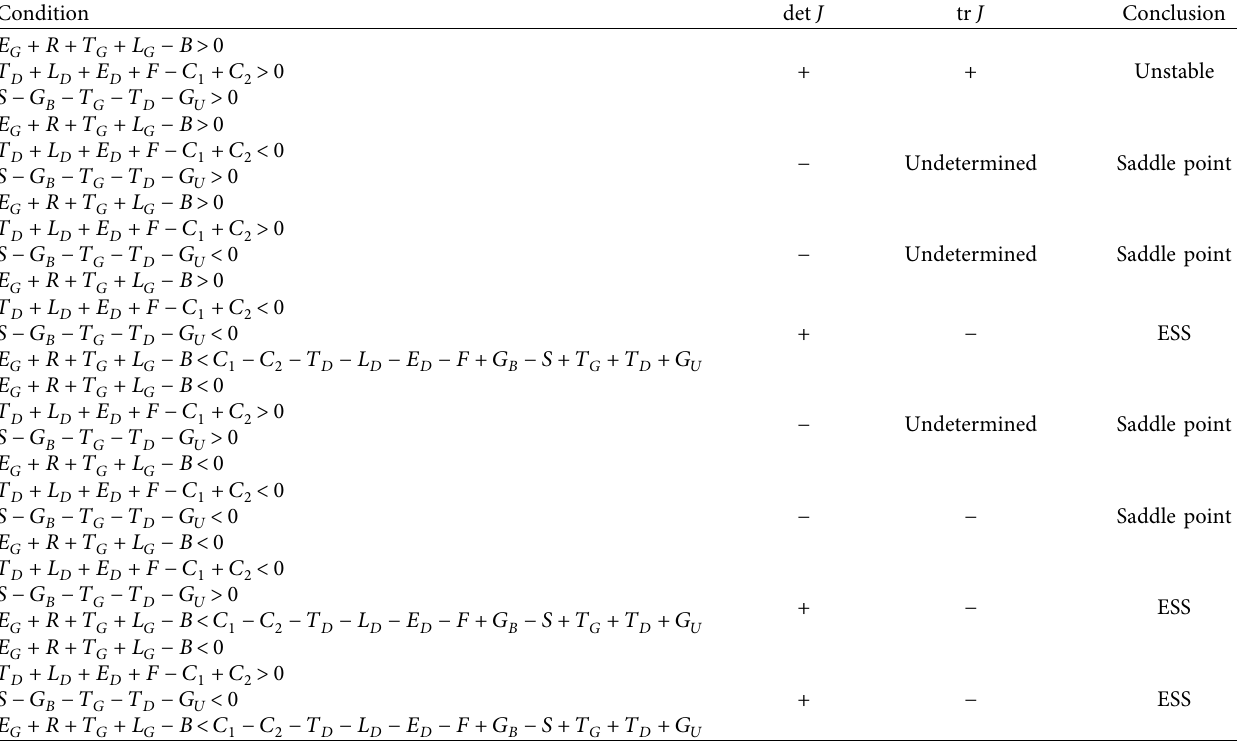
Table 5: Stability discussion of point F (1, 1, 1).